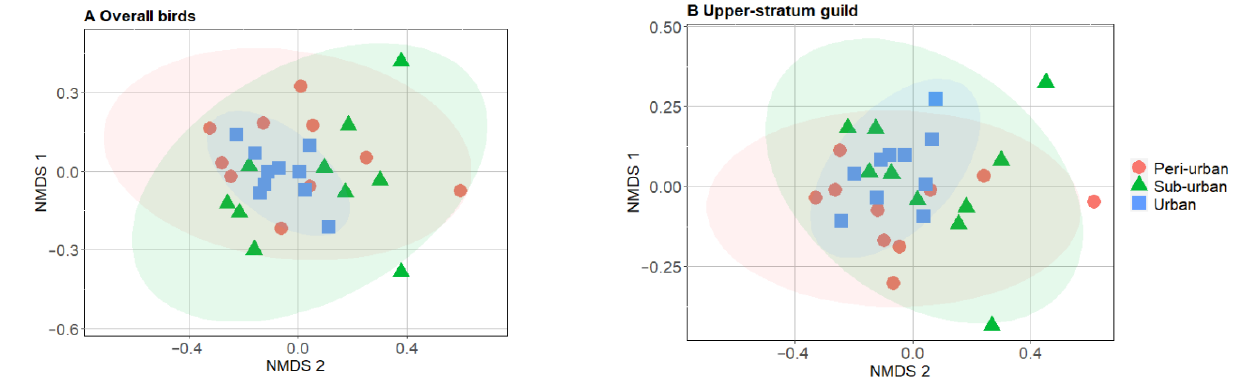
Figure 6. NMDS two-dimensional plot of overall birds ( A ) and upper-stratum guild ( B ) from 30 sampling transects (10 urban = blue squares, 10 peri-urban = red circles, 10 sub-urban = green triangles). The stress values of overall birds and upper-stratum guild were 0.155 and 0.183, respectively.